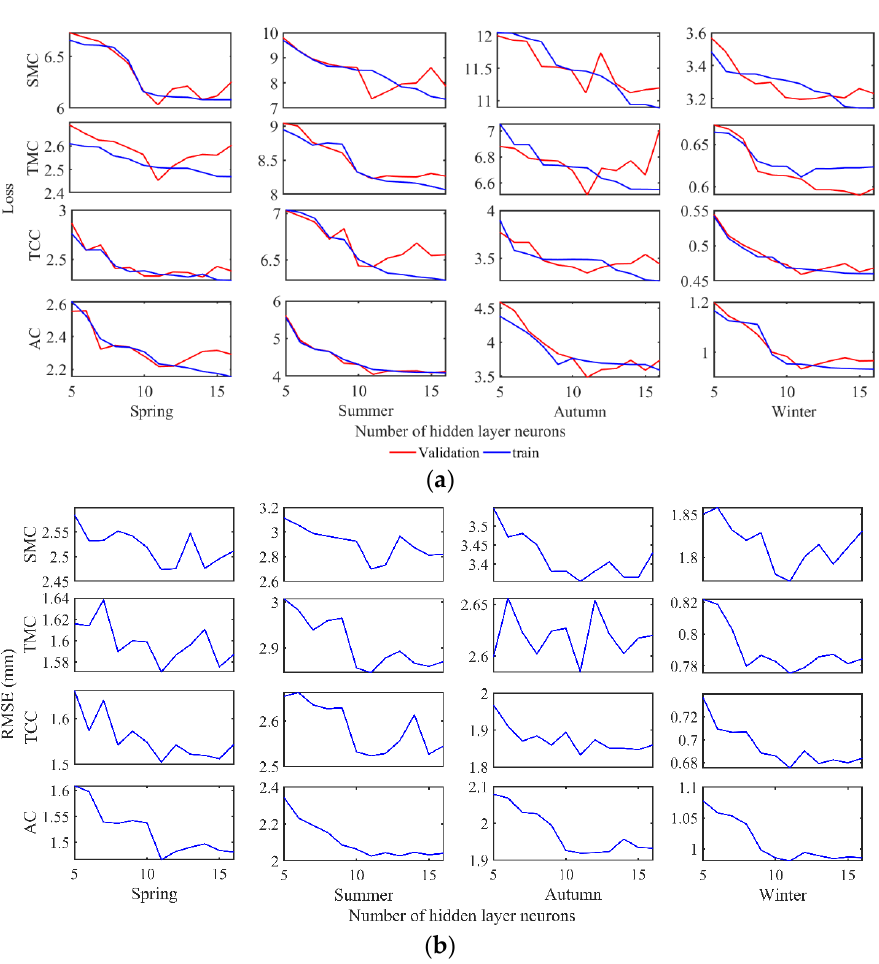
Figure 5. ( a ). Model training and validation loss of the BPNN model under different numbers of hidden layer neurons. ( b ). RMSE of the BPNN model under different numbers of hidden layer neurons. Figure 5b is the result of external test data correction using the trained models of different hidden layer neurons. The RMSE corrected by the seasonal models for external data decreased first and then increased, and the minimum value was obtained when the number of neurons in the hidden layer was 11. Combined with the above verification by the loss function, the optimal number of neurons in the hidden layer was determined to be 11.